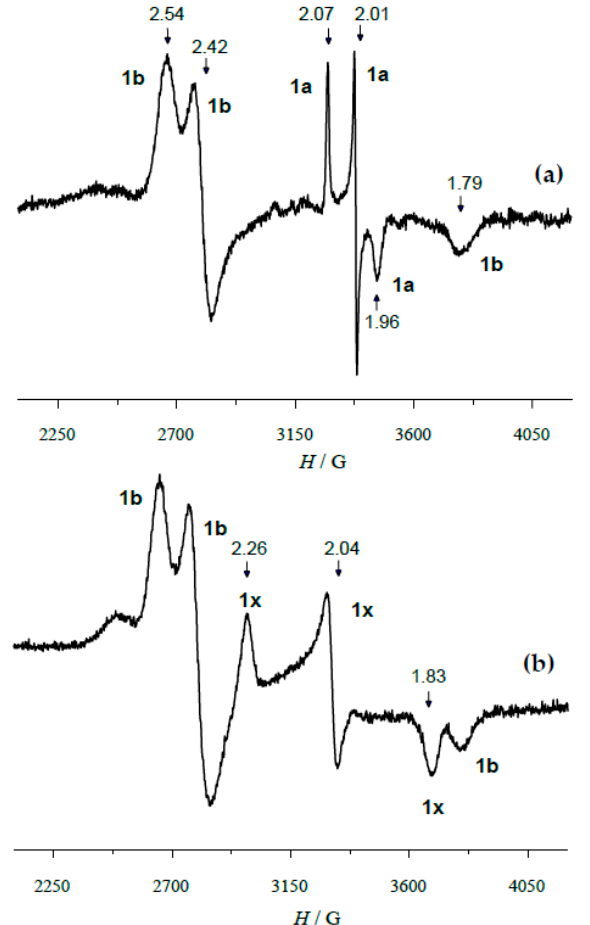
Figure 3. EPR spectrum ( − 196 ° C) of the catalyst system 1 /H 2 O 2 /AA = 1:3:5 ([ 1 ] = 0.02 M) in a CH 2 Cl 2 /CH 3 CN (1.8:1 v / v ) mixture recorded 3 min after mixing the reagents at − 75 ° C ( a ). EPR spectrum ( − 196 °C) of the sample 1 /H 2 O 2 //HClO 4 = 1:3:2 ([ 1 ] = 0.02 M) in a CH 2 Cl 2 /CH 3 CN (1.8:1 v / v ) mixture recorded 6 min after mixing the reagents at − 40 ° C ( b ). The signals denoted by symbol 1b belongs to the stable ferric complex [( Me2OMe PDP)Fe III (OAc)] 2+ .